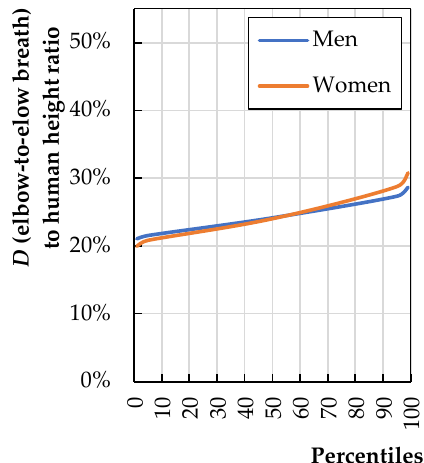
8 of 15 Figure 6. Ratio of bi-trochanteric breadth ( C ) to total human stature ( H ) (calculations based on liter- ature data [20]). Assuming two-centimeter spacings on both sides, Equation (3) can be written: 𝑏 (cid:2871) = 0.25 ∙ 𝐻 (cid:2877)(cid:2873)(cid:2930)(cid:2918) (cid:2933)(cid:2925)(cid:2923)(cid:2911)(cid:2924) + 2 ∙ 2 cm (3) Using Formula (3) and based on a contemporary 173.1 cm-tall 95th-percentile woman